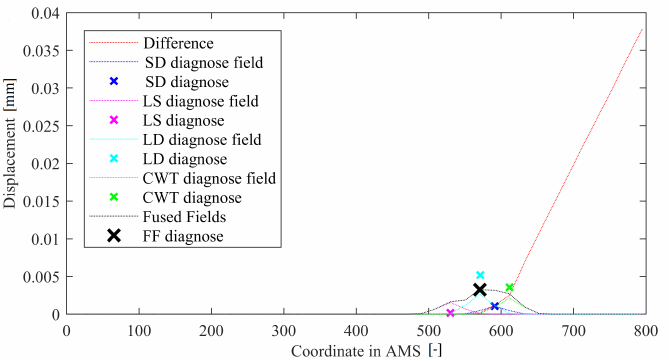
Figure 10. Example of operation of a FF method.